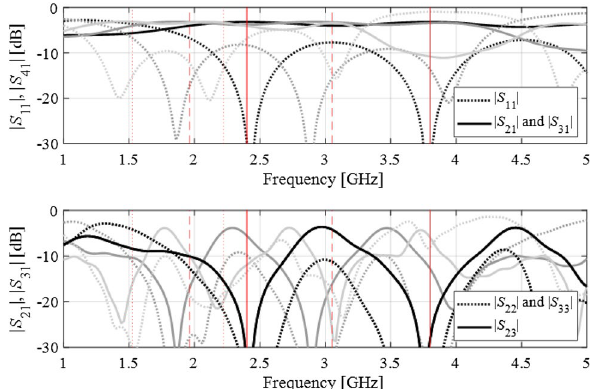
Figure 16. Dual-band power divider: scattering parameters at the three intermediate designs, marked using the light-gray, dark-gray, and black colors (optimum), along with the corresponding target frequencies. For clarity, the input matching and transmission responses, as well as the output matching and isolation responses are shown in separate